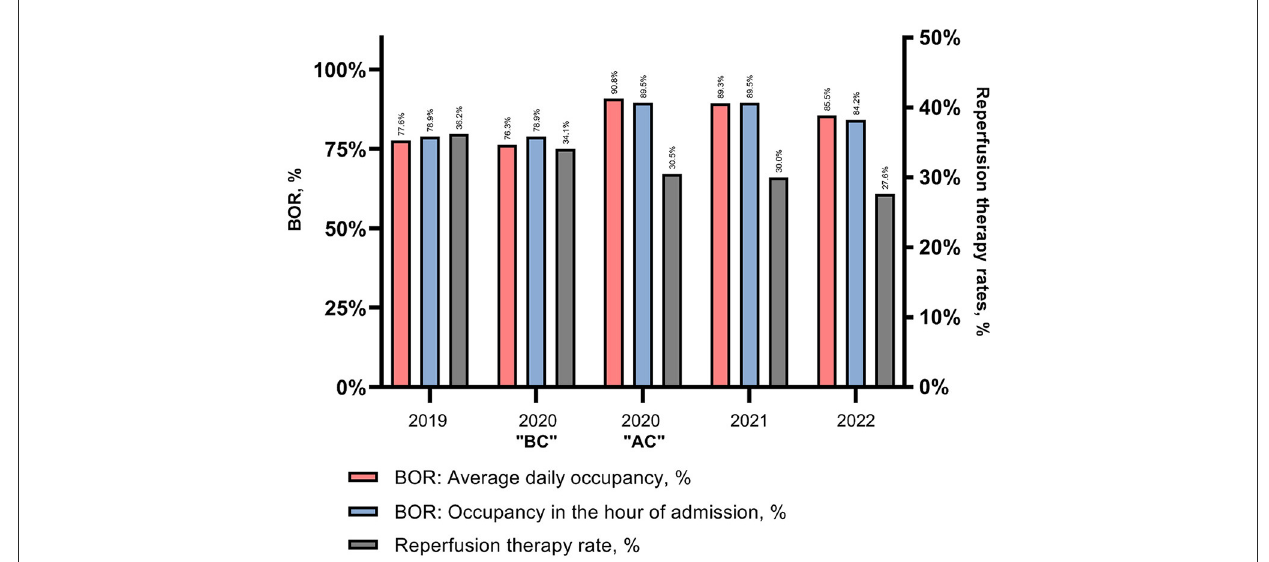
FIGURE1 Stroke center BOR and reperfusion therapy rates. Bed occupancy from 2019-2022 examined on the day of admission and in the hour of admission. BOR, Bed occupancy rate; BC, Before centralization of rehabilitation beds; AC, After centralization.